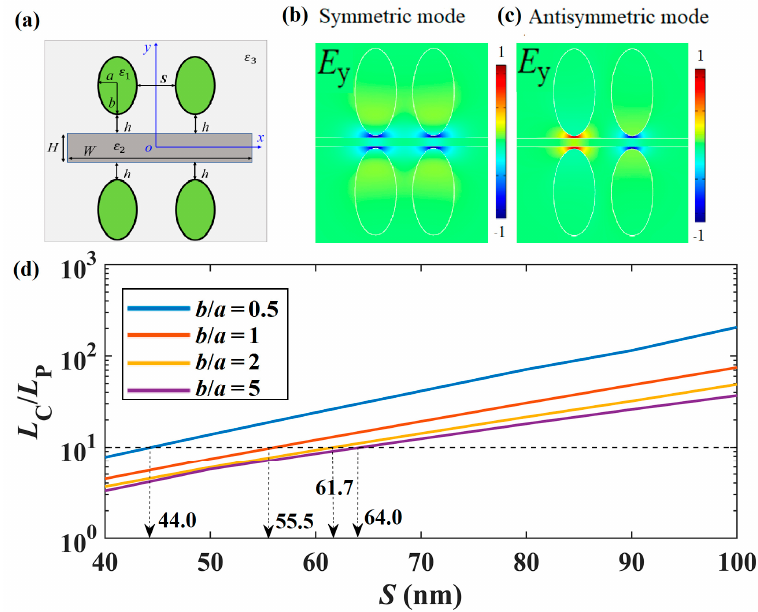
Figure 7. Crosstalk between SGPWGs. ( a ) Coupling system; ( b ) and ( c ) for normalized E y field distributions of symmetric and antisymmetric modes when b / a = 2 and S = 40 nm; ( d ) L C / L P with respect to S for different b / a values.